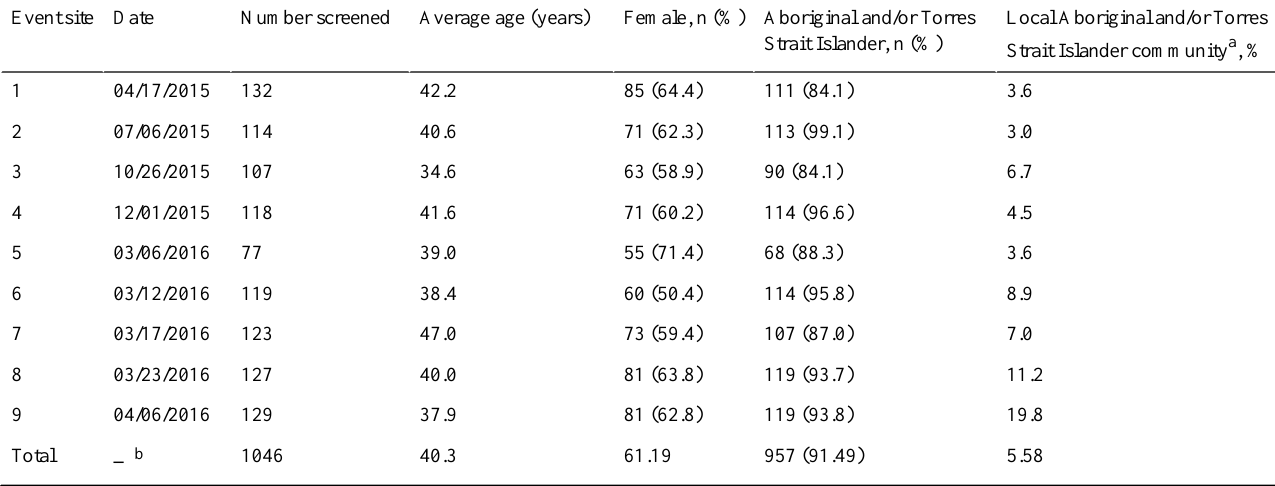
Table 2. Demographic profile of participants screened.